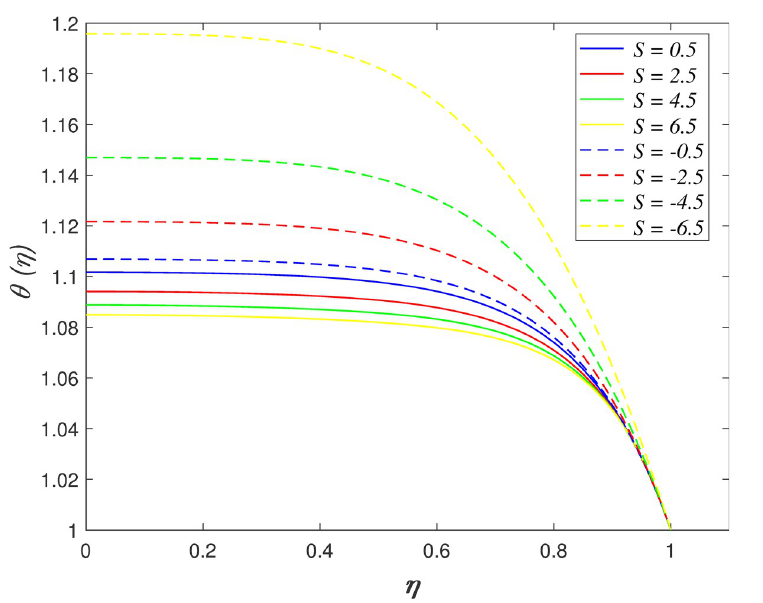
Fig 4. Impact of S on temperature.